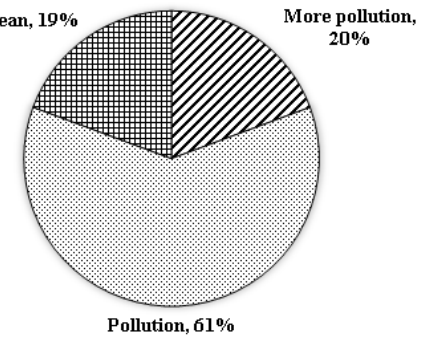
Figure 7. Sensory assessment of water quality in the study area quality in LNHNR.